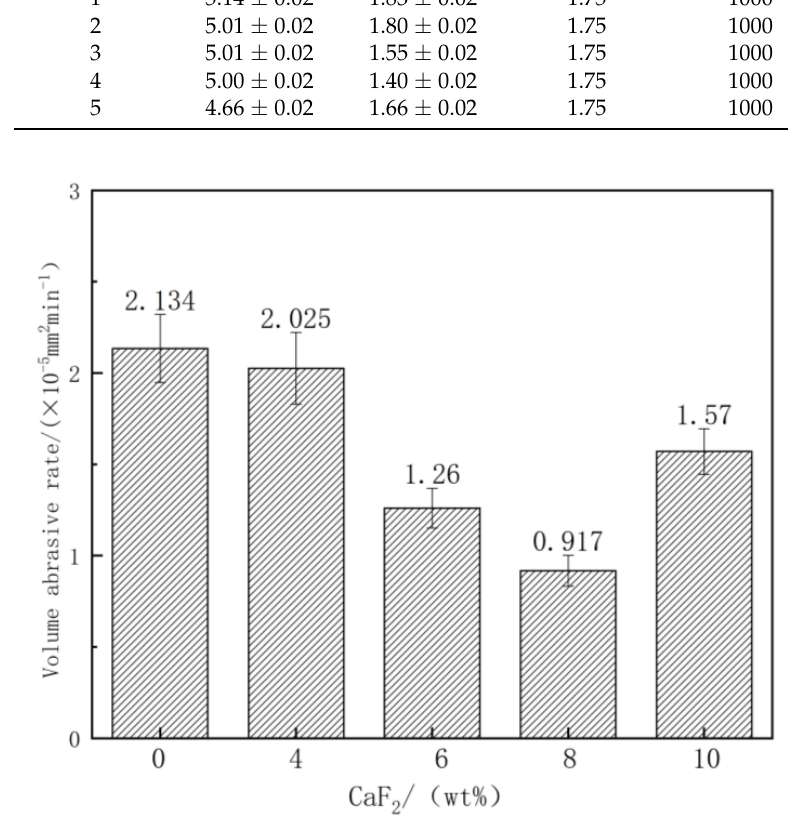
Figure 4. Abrasive wear rate of disc with different CaF 2 content.